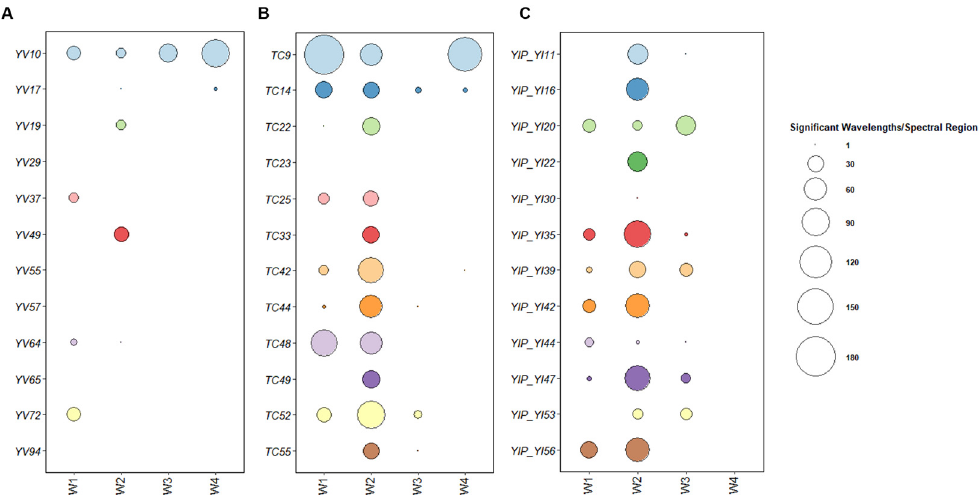
Figure 4. Number of significant different wavelengths detected in the comparison between each S. cerevisiae parental strain and the selected 12 MSCs. Spectra were compared using the Student’s t -test for each wavelength separately. The number of wavelengths with statistically significant difference ( p < 0.01) was calculated for each specific spectral area separately, namely: fatty acids (W1), amides (W2), mixed region (W3) and carbohydrates (W4) regions. ( A – C ): MSCs of YVGC13A, TC1517 and YI30, respectively.